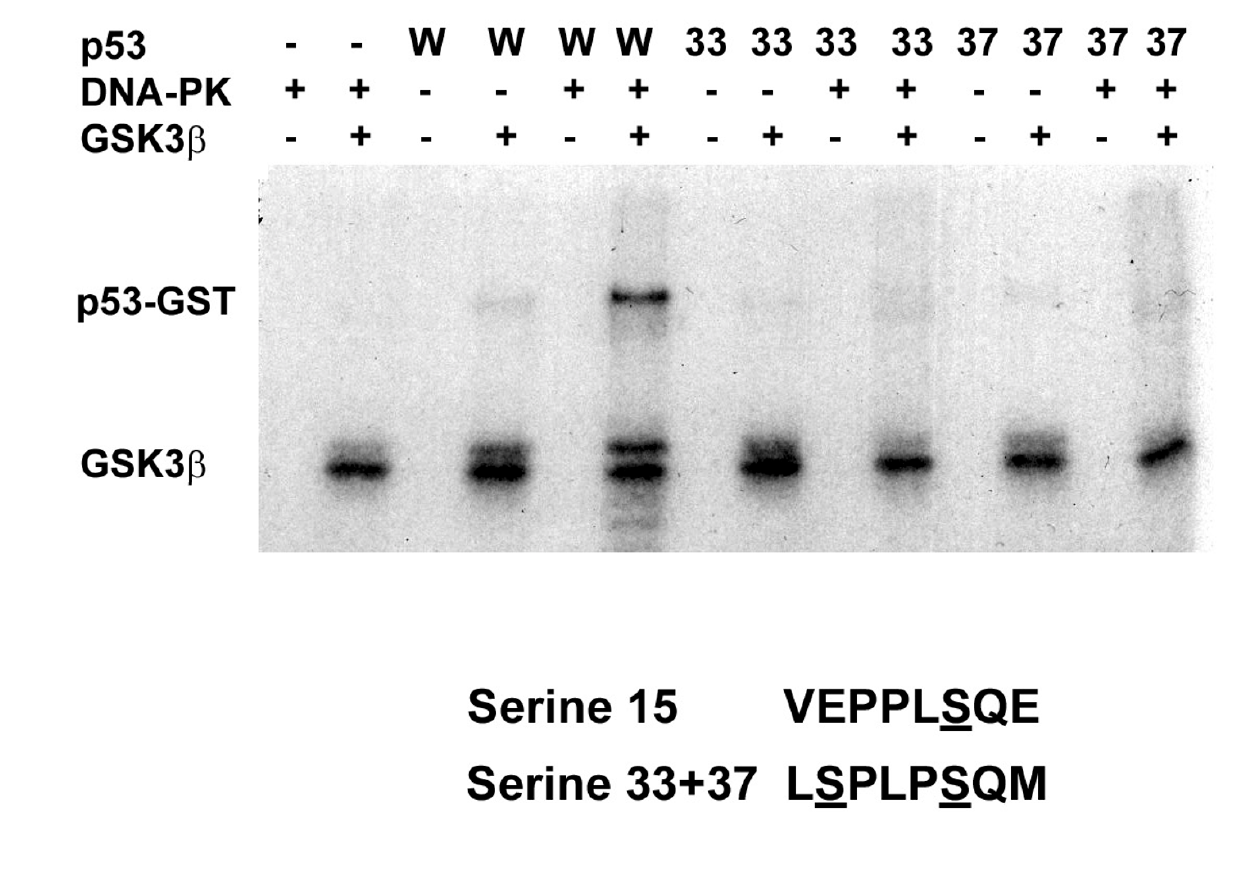
Figure 2 GSK3 β phosphorvlates serine 33 of p53. wtp53-GST (W), p53-GSTS33A (33) or p53-GSTS37A (37) were preincubated in buffer (-) or DNA-PK (+) for 5 h in the presence of excess ATP. Following heat inactivation of the DNA-PK, aliquots of the phosphorylated p53-GST fusion proteins were incubated for 30 min without (-) or with (+) GSK-3 β . Position of p53-GST